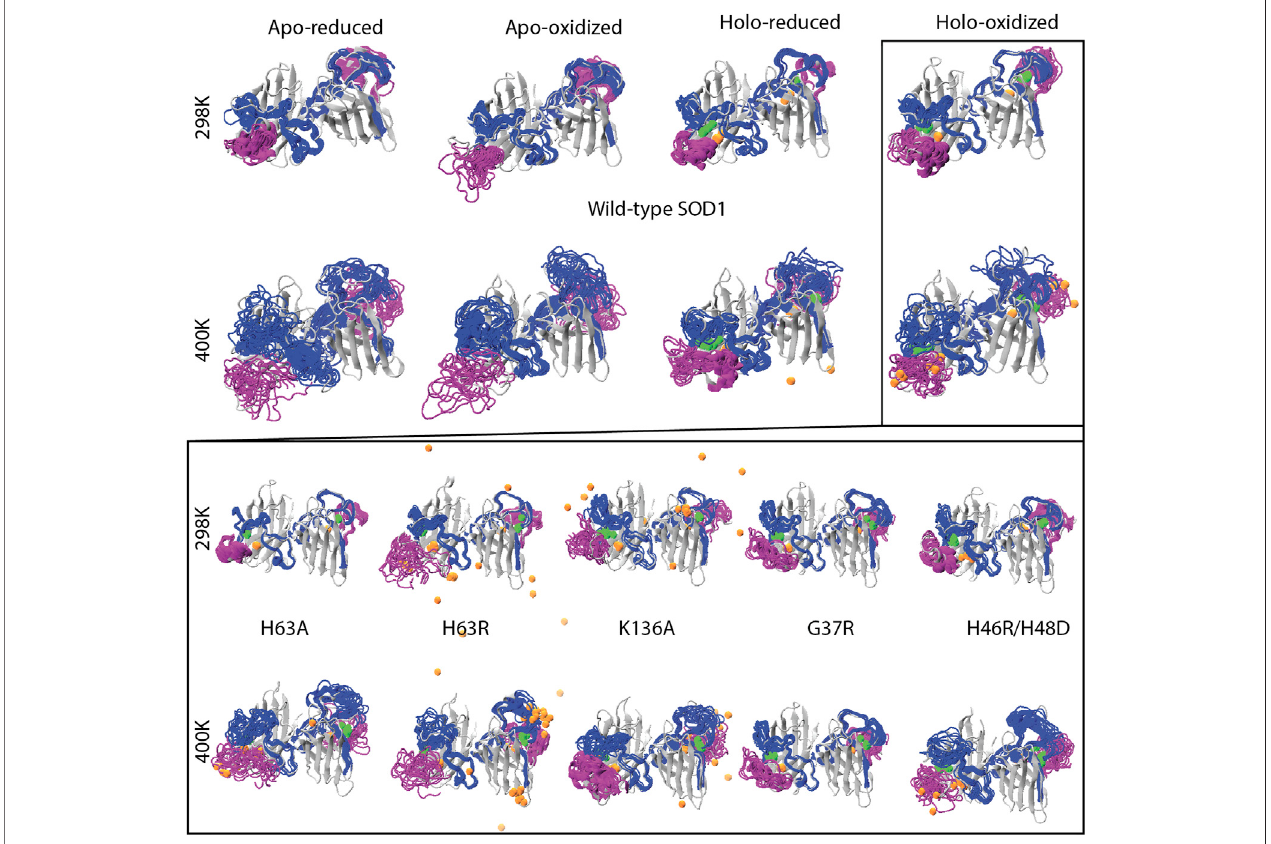
FIGURE 5 | Reduced trajectories of the metal binding loops spanning the residues from 48 to 89 (blue) and from 124 to 139 (purple) were shown for the wild-type dimer in the top two panels for all four systems. Five variants in the holo-oxidized forms were similarly visualized in the bottom two panels. For all plots, Cu and Zn ions were colored orange and green